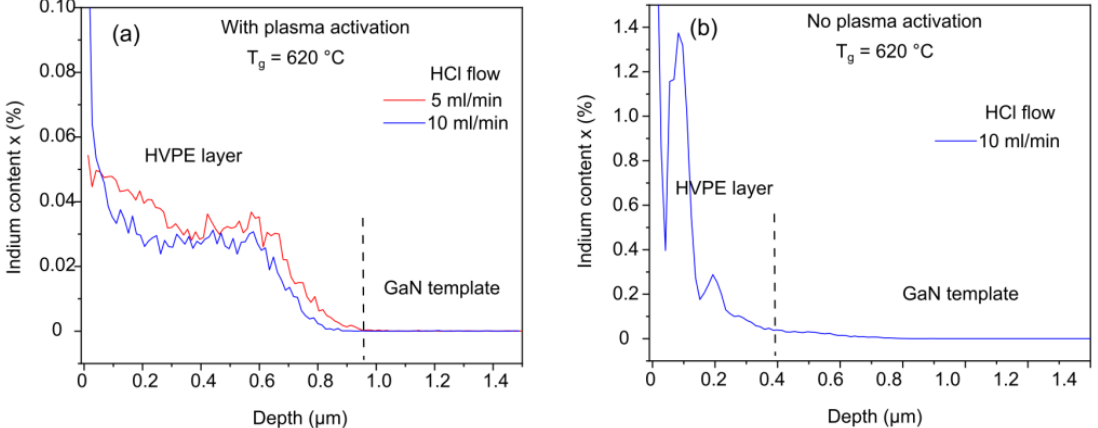
Figure 7. ( a ) SIMS depth profile for indium concentration for samples grown with ammonia activated by plasma. ( b ) SIMS profile for the sample grown with the same parameters as in ( a ) but without activation of ammonia by plasma. The indium boat temperature was 320 °C. The dashed lines are a guide to the eye.